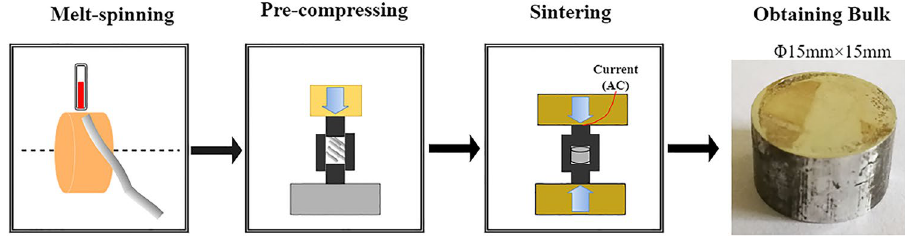
Figure 1. Schematic diagram of preparing the sintering RS Mg–Gd–Zn